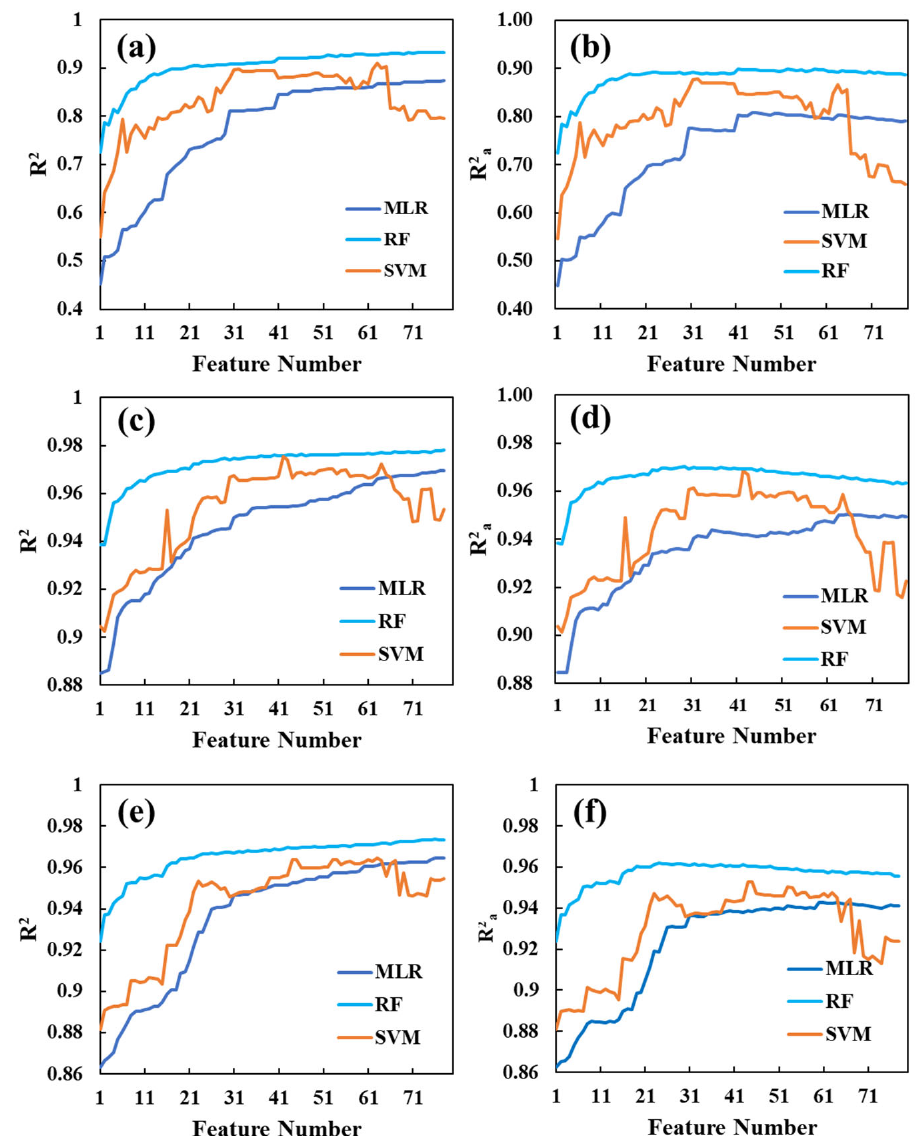
Figure 10. The performance of three machine learning methods trained over dataset IV with the number of input features changed. The number of features is the order sorted by the correlation coefficient (r). ( a , c , e ) is the change in the coefficient of determination (R 2 ) of the LCD, LAI, and CCD estimation models with the number of input features. ( b , d , f ) is the change in the adjusted coefficient of determination (R 2 a ) of the LCD, LAI, and CCD estimation models with the number of input features.